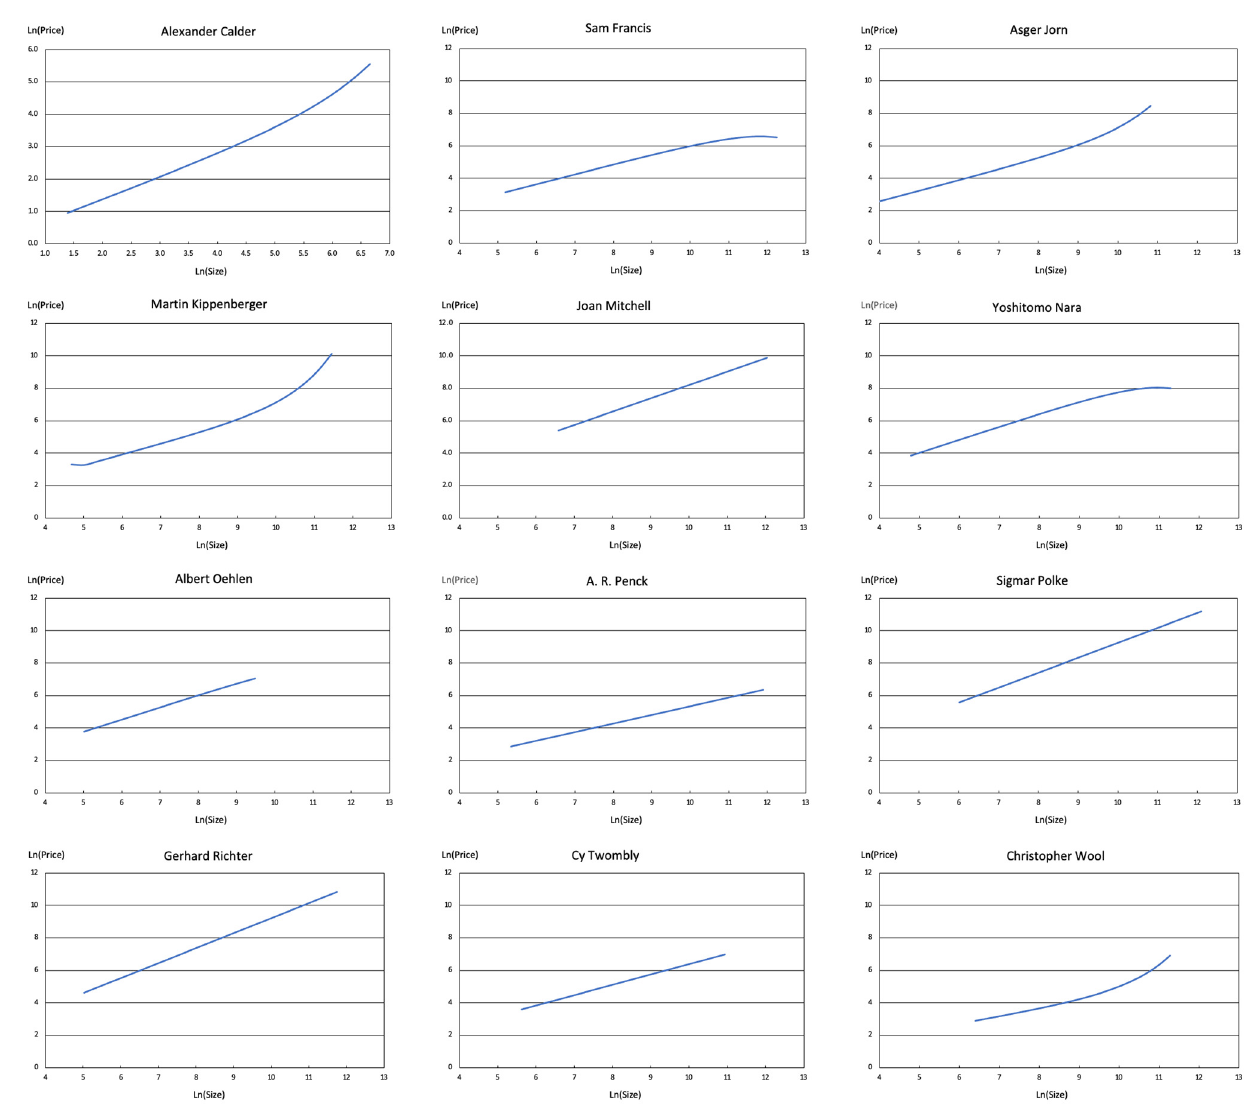
Figure 1. Size-price profiles for each artist. 11